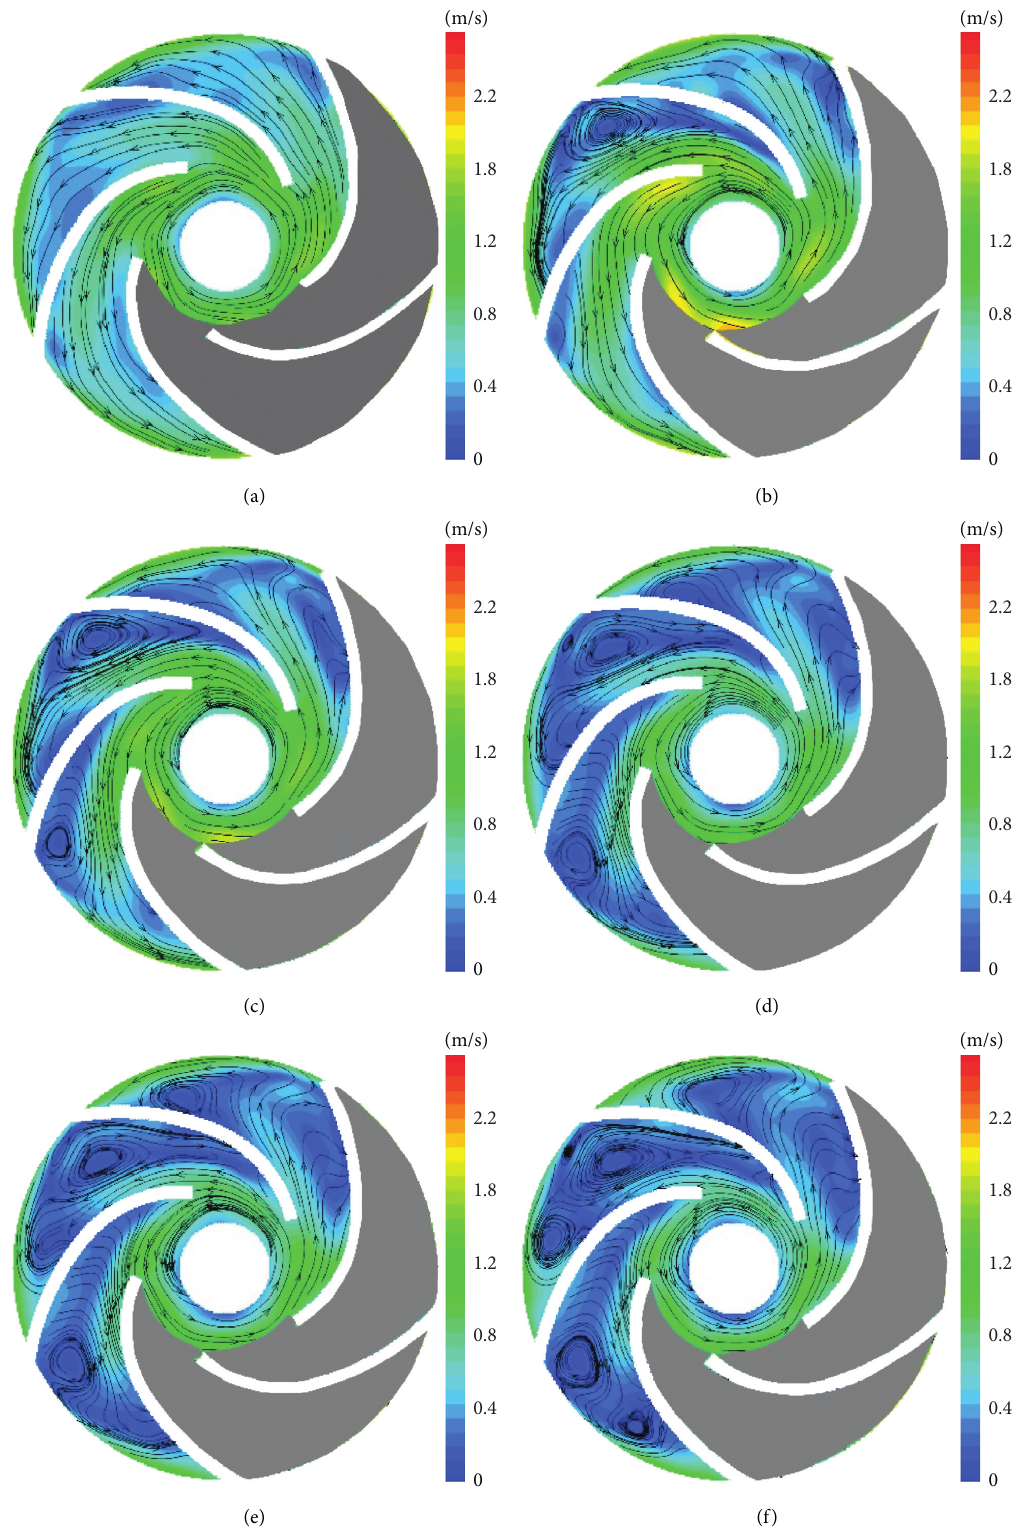
Figure 7: Phase-averaged relative velocity and flow streamlines at the middle span of the impeller: (a) 1.2 Q 0.6 Q BEP , (e) 0.4 Q BEP , and (f) 0.2 Q BEP